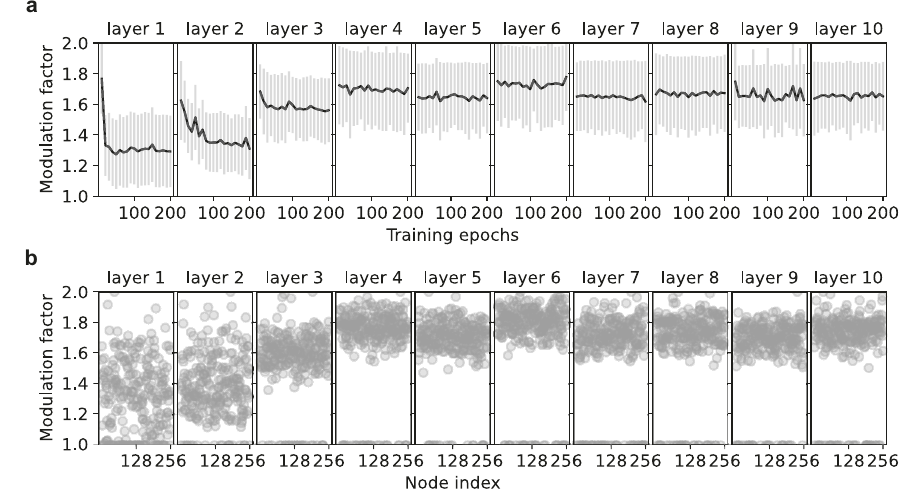
Fig. 3 Dynamics of the modulation factor. a Mean and standard deviation dynamics of the modulation factors for a 10 × 256 tanh network, with 10% dropout, trained with BP, SGD, and GRAPES modulation for 200 training epochs. The modulation factors are recorded for each layer every 10 epochs. b Distribution of the modulation factors at the end of